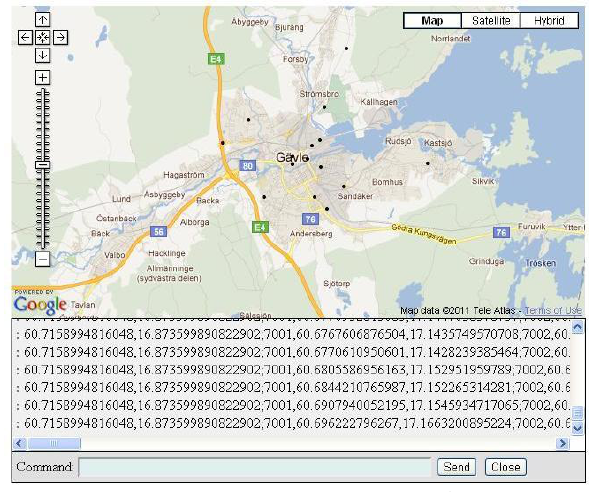
Figure 2. Dynamic visualization interface.